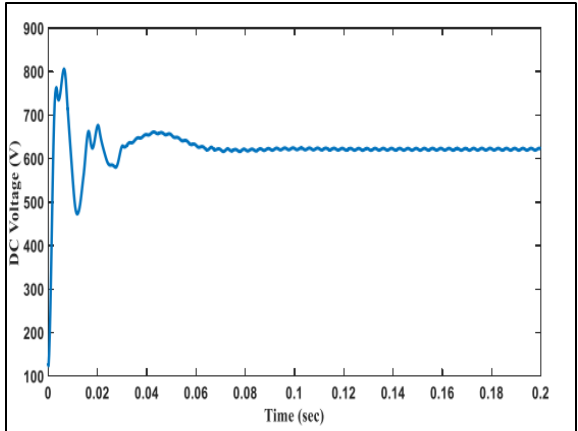
Figure 29. DC-Link Capacitor Voltage.